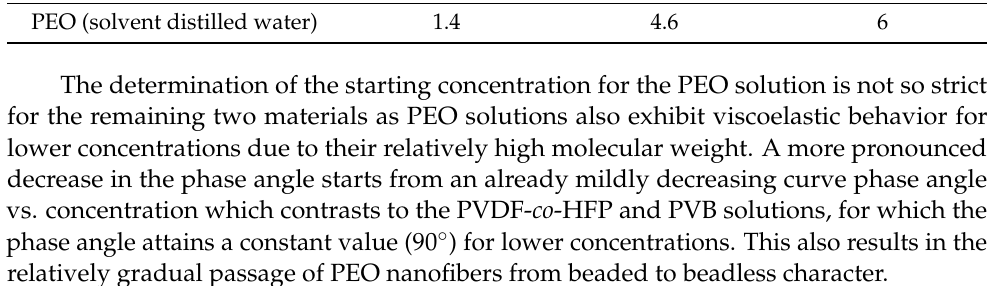
Overlap Entanglement Starting Concentration Concentration c e * Concentration c * (wt.%) c start (wt.%)